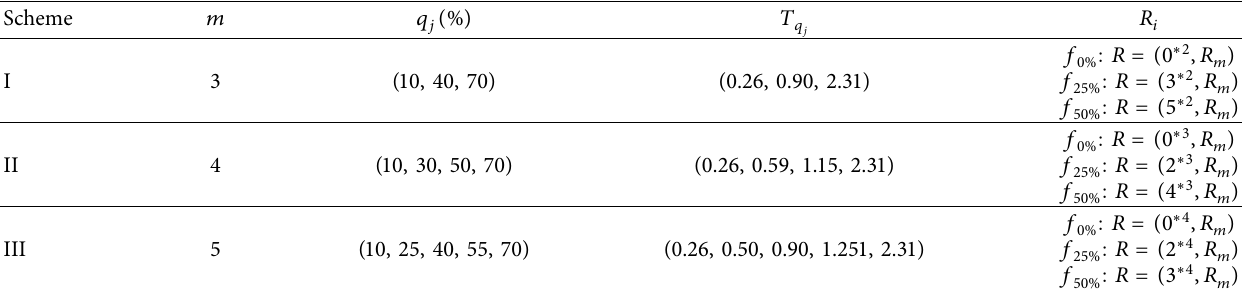
Table 7: Removal patterns of units under different censoring schemes for data set I.